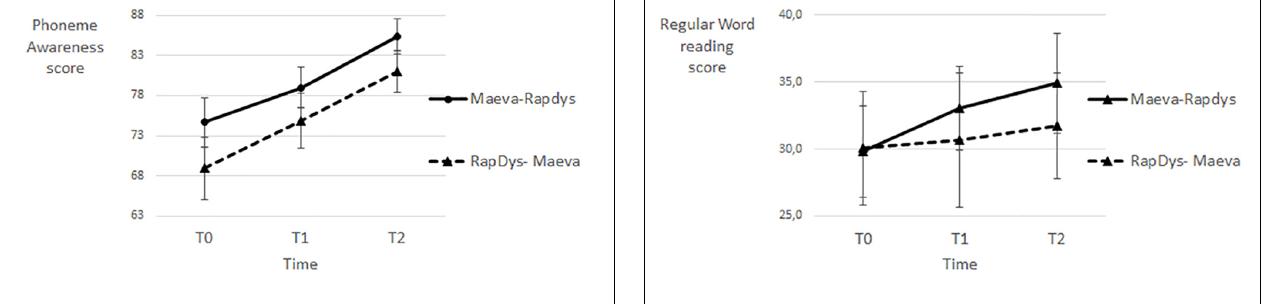
FIGURE 5 | Phonemic awareness scores for each time period and each presentation order.